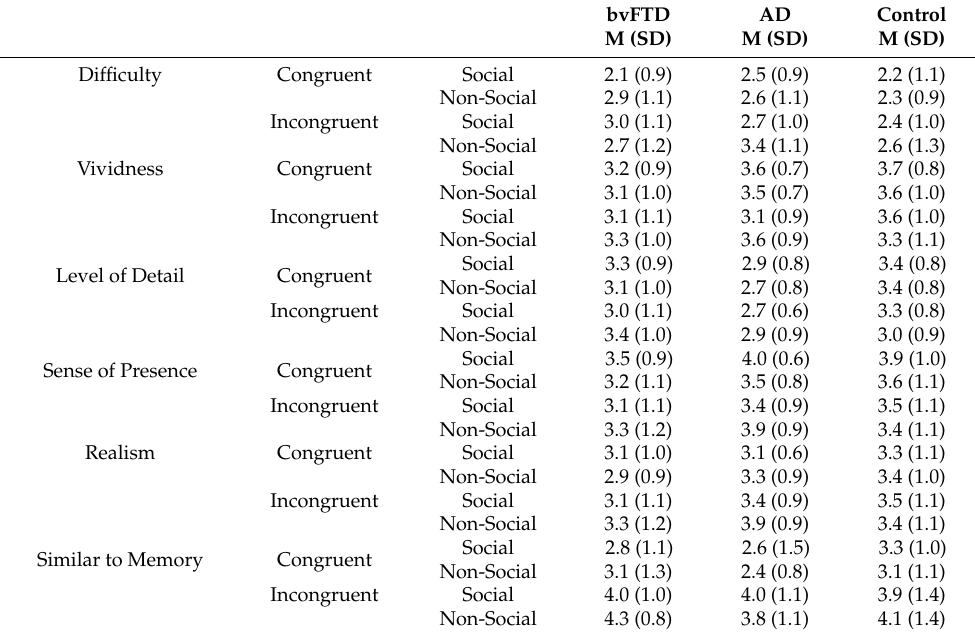
Table 3. Subjective ratings for each condition in participant groups.